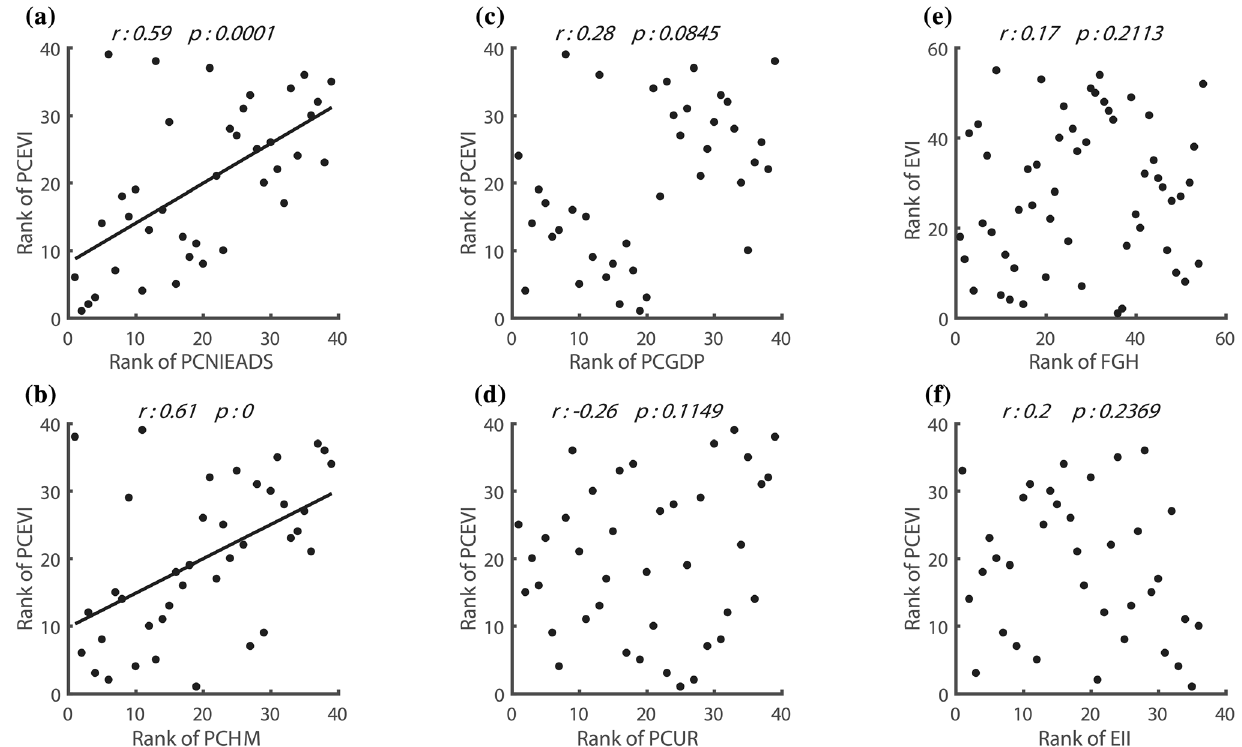
Fig. 4 Results of the Spearman’s rank correlation test. PCEVI denotes the percentage change of the ecological vulnerability index; PCNIEADS denotes the percentage change of the number of industrial enterprises above the designated size; PCHM denotes the percentage change of highway mileage; PCGDP denotes the